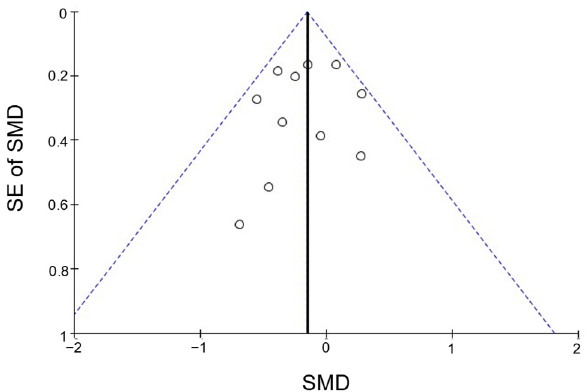
Figure 3. Funnel plot of studies included in the meta-analysis on fasting blood glucose ( n = 11 trial arms). The vertical solid line represents the pooled effect size, and the dashed lines represent the 95% confidence interval. SMD, standardized mean difference; SE, standard error.